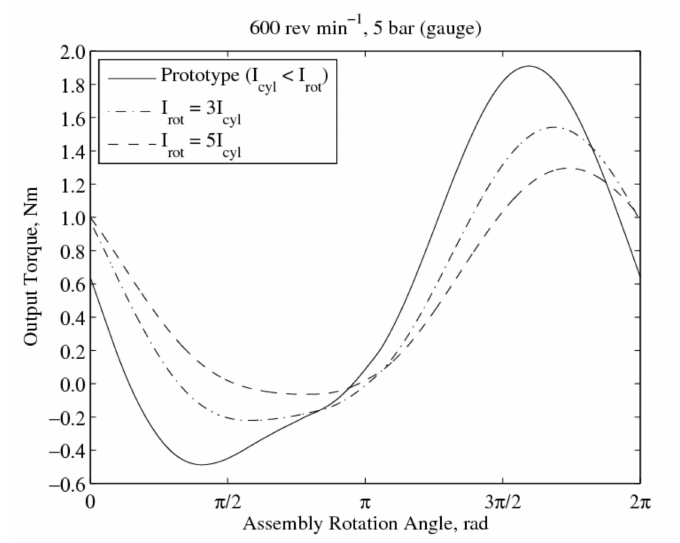
Figure 11. E ff ect of rotor inertia on output torque.